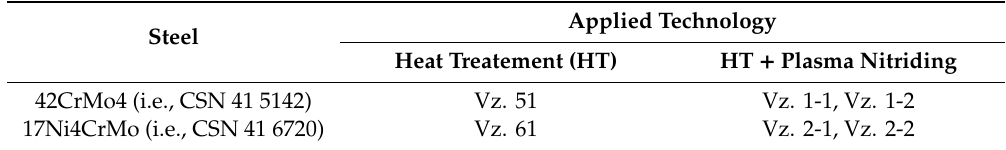
Table 2. Marking of specimens used in